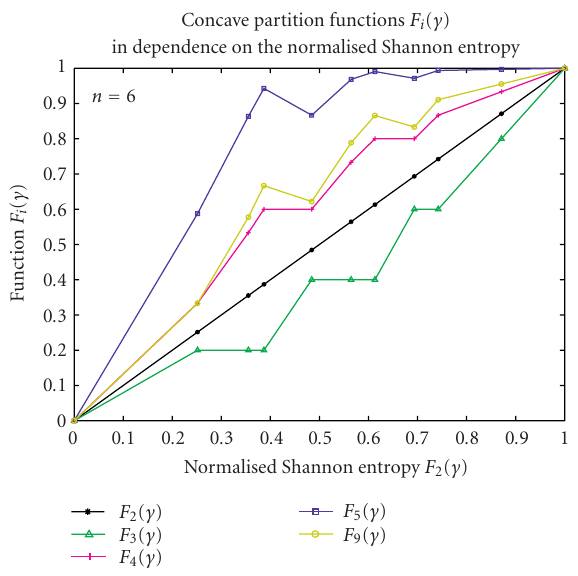
Figure 4.14. Dependence of concave partition functions F i ( γ ) on the normalised Shannon entropy of the Young diagrams in case of n = 6.